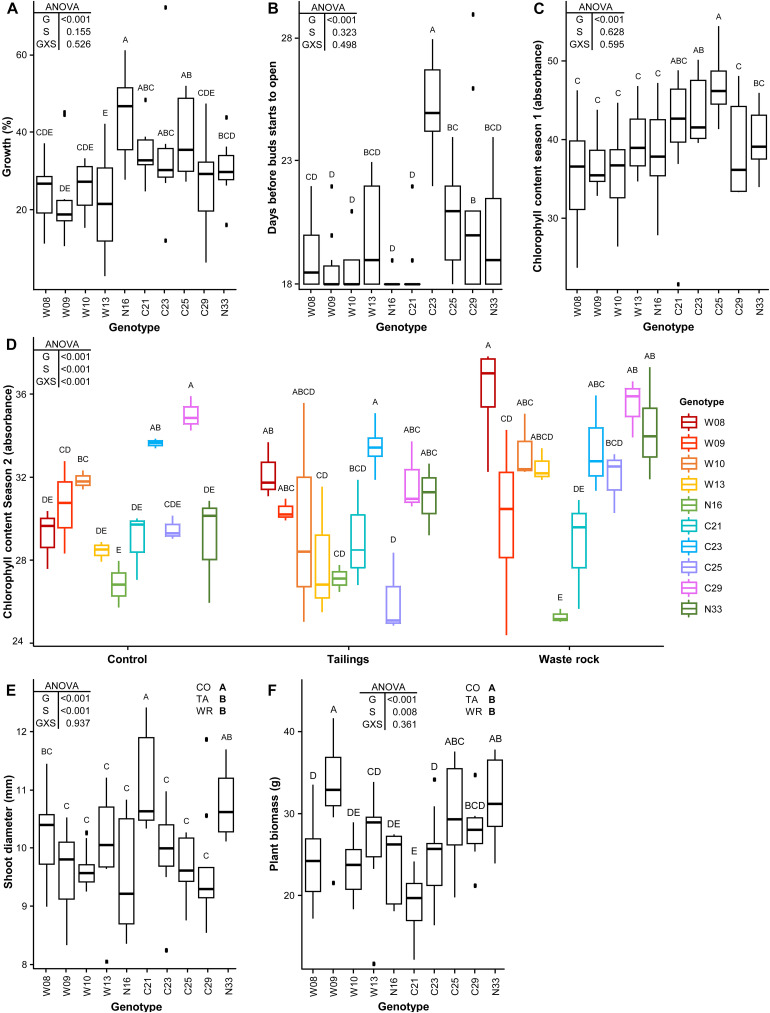
Effect of genotype and substrate type on tree growth measurements. Tree growth during the first season (A); chlorophyll content at the end of the first (B) and second (C) seasons; blooming during the second season (D); shoot diameter (E); and biomass produced during the second season (F). A two-way ANOVA was used to discern how genotype, substrate type and their interaction influenced tree growth measurements. Shared letters between treatments means there is no significant difference between these treatments as determined by Tukey HSD post hoc pairwise comparison test (n ≥ 3). In the ANOVA tables, G is genotype; S is substrate type; and GXS is the interaction between genotype and substrate type. In (E) and (F) CO is control; TA is tailings; and WR is waste rock. Significance level is p < 0.05. In (A–C), because only the effect of genotype is significant, measures from all substrate types were pooled. In (D), because the interaction of both factors is significant, all treatments were shown separately. In (E) and (F), pooled measures from all substrate types are shown for each genotype as a boxplot and the effect for each substrate type is shown in the upper right corner of the plots.